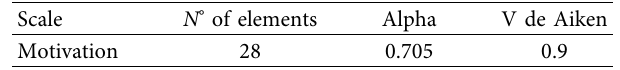
Table 1: Validation and